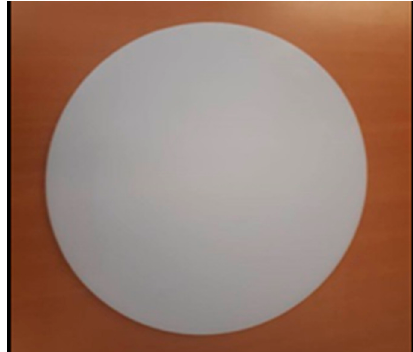
Figure 1. PMSQ–HDPE membrane.